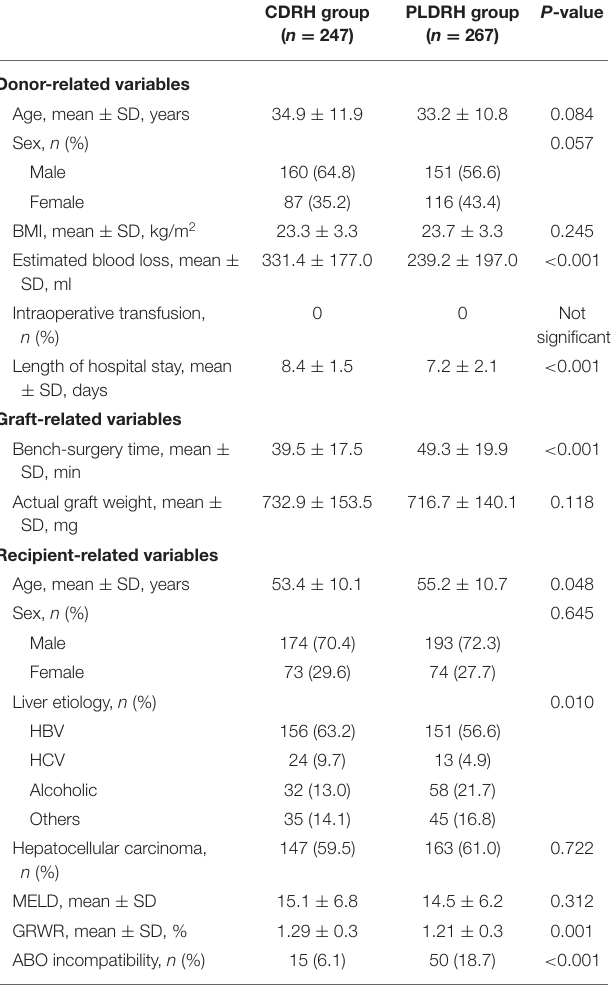
TABLE 1 | Demographic characteristics of donors, liver grafts, and recipients. TABLE 2 | Proportion of participants with vascular variation related to the graft in the CDRH and PLDRH groups.